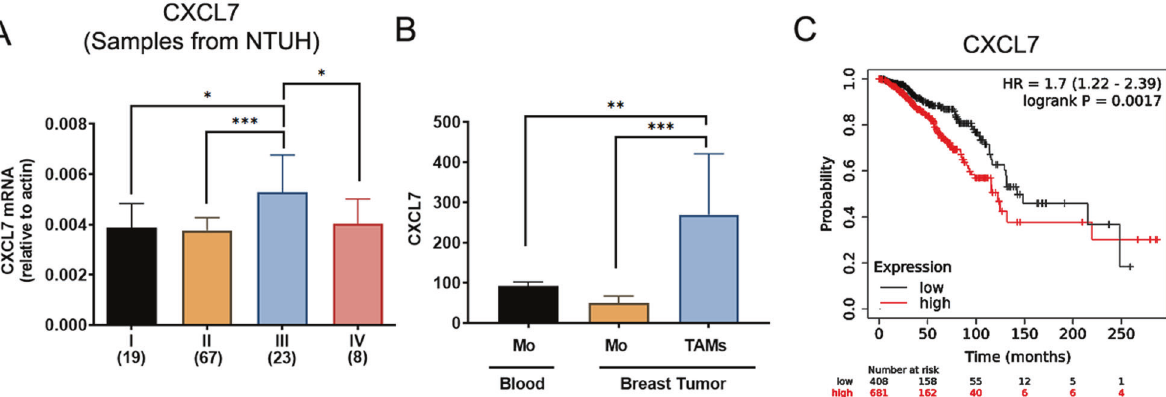
Fig. 5 CXCL7 level is elevated in stage III breast carcinoma and correlates with poor survival. A Expression of CXCL7 in 117 breast carcinoma samples from NTUH was determined by real-time RT-PCR analysis. Samples were sub-grouped by TNM stages. The case number of each stage is indicated at the bottom of the graph. Data represent the means ± SEM. (* p < 0.05; *** p < 0.001). B The mRNA expression of CXCL7 in circulating human monocytes ( n = 61), human monocytes from breast tumor ( n = 23), and human tumor associated macrophages from breast tumor ( n = 4). RNAseq data were obtained from publicly available dataset (GSE117970). Data represent the means ± SEM (** p < 0.01; *** p < 0.001). C Kaplan – Meier plots showing the association of CXCL7 expression with overall survival (OS) of breast cancer patients from KM plotter breast cancer sample RNA-seq datasets. The statistical signi fi cance was determined using the χ 2 test.